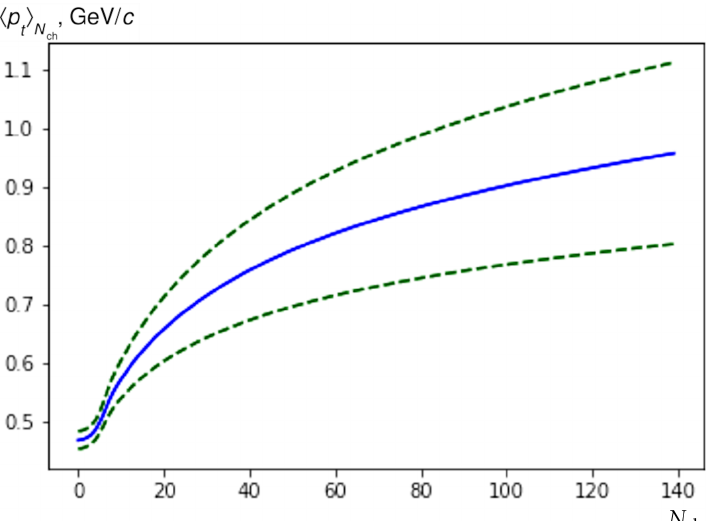
Figure 11. Prediction for (cid:104) p t (cid:105) - N ch correlation function for pp collisions at 100 TeV (the width of the pseudorapidity interval ∆ η = 2.0). Dotted lines show the area of one standard deviation.